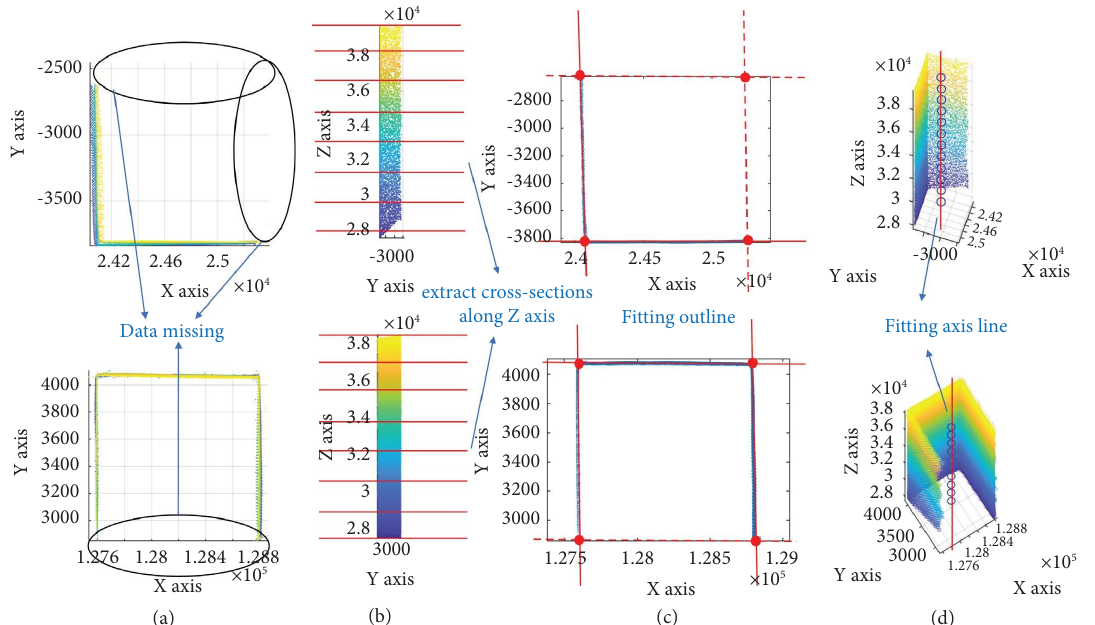
Figure 5: Illustrations of axis line for pier column and tie beam: (a) original point clouds, (b) extracted cross sections along the Z -axis, (c) ftting outline, and (d) ftting axis